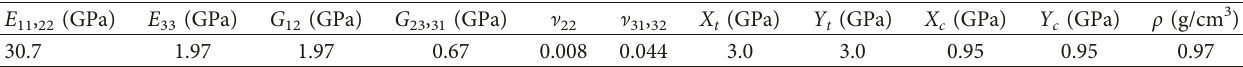
Table 5: Mechanical properties of